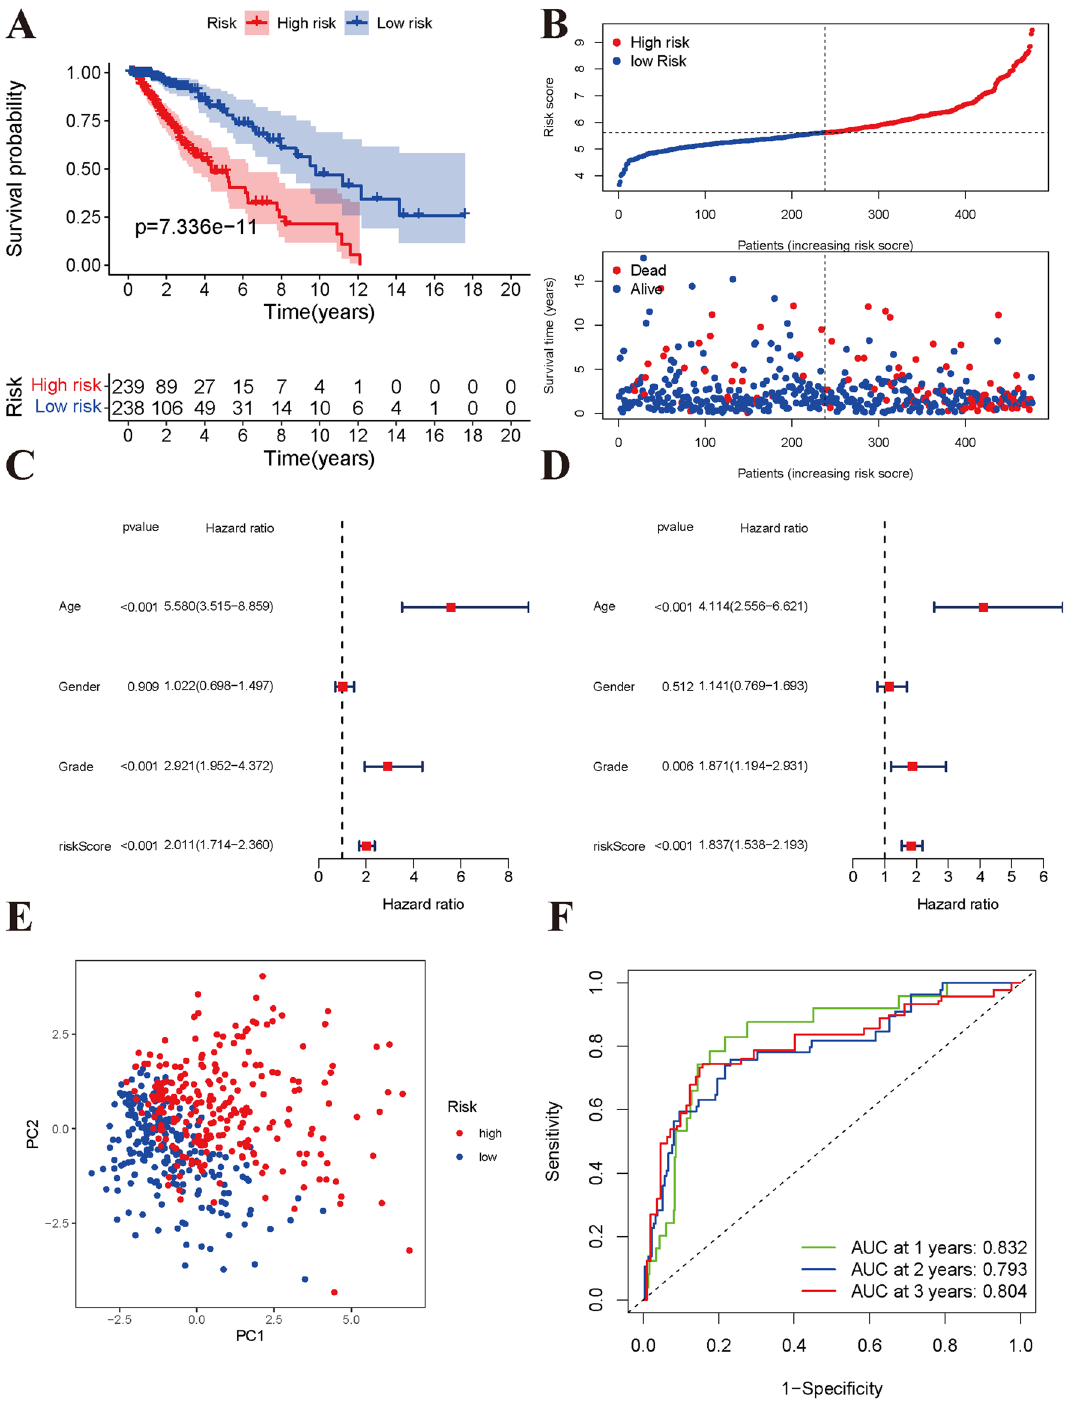
Figure 4. Validation of prognostic model based pyroptosis genes in TCGA cohort. ( A ) Kaplan–Meier survival curves of high- and low-risk groups divided by risk score. ( B ) Distributions of risk score and survival time in different risk groups. ( C ) Univariate cox analysis identified the correlation of risk score and overall survival in low-grade glioma. ( D ) Multivariate cox analysis identified the correlation of risk score and overall survival in low-grade glioma. ( E ) Principal component analysis showed two markedly distributions for high- and low-risk groups. ( F ) The predict ability of risk score for 1-year, 2-year, and 3-year overall